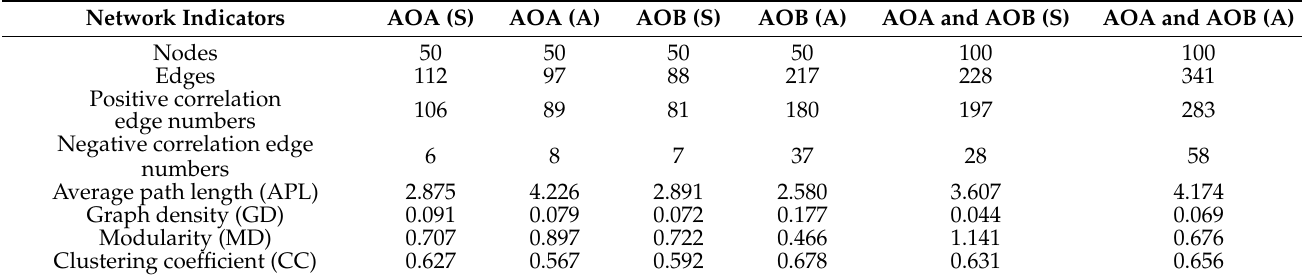
Figure 7. Co-occurrence network of ammonia oxidizing bacteria communities in different seasons. The AOA community in spring ( a ) and autumn ( b ), AOB community in spring ( c ) and autumn ( d ), AOA and AOB communities in spring ( e ) and autumn ( f ). A link represents a significant correlation (Spearman, | ρ | > 0.8, p < 0.05). The blue line represents positive correlation and the red line represents negative correlation. The node size is proportional to the number of connections. A and B after OTUs represent AOA and AOB, respectively. Only the groups with the top 50 average relative abundance of AOA and AOB were shown. Table 4. Topological properties of co-occurrence network of AOA and AOB in spring and autumn.